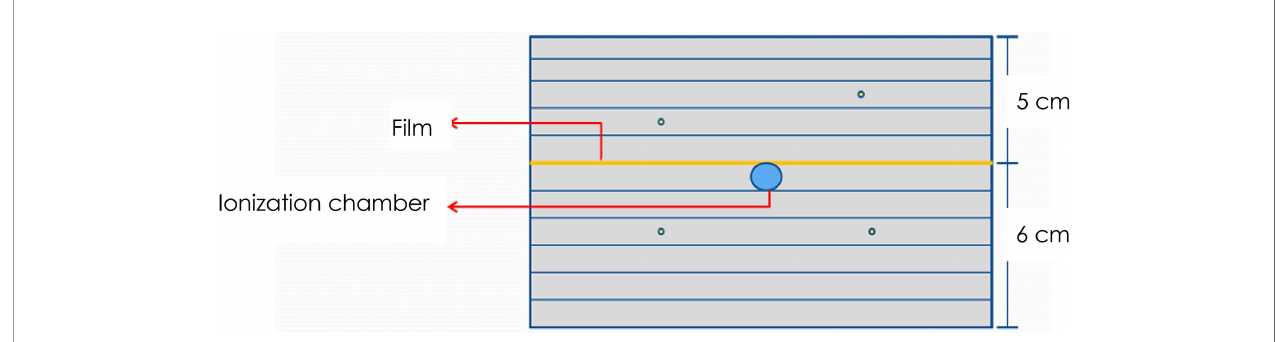
FIGURE 1 | Schematic layout of the dose measurement using the PinPoint ionization chamber and EBT3 fi lms. A total of 4 fi ducial markers were implanted into the phantom to facilitate automatic phantom set-up by fi